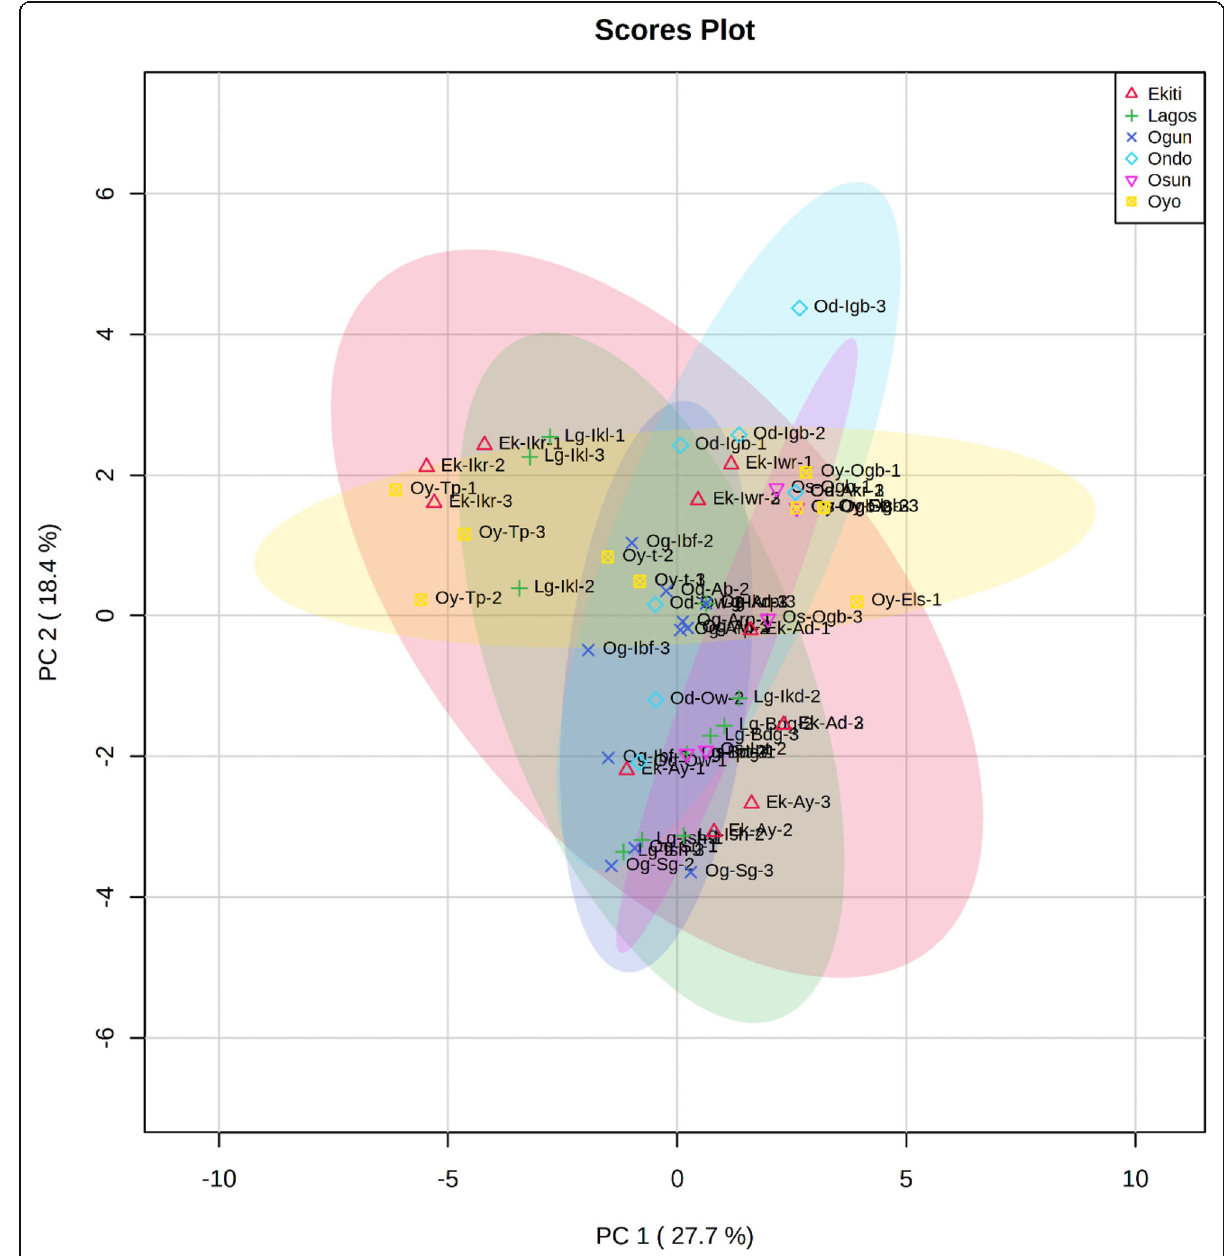
Fig. 8 PCA plot of all the results from different locations. The groups from Ekiti are in red, Lagos in green, Ogun in deep blue, Ondo in light blue, Osun in fuchsia pink and Oyo in